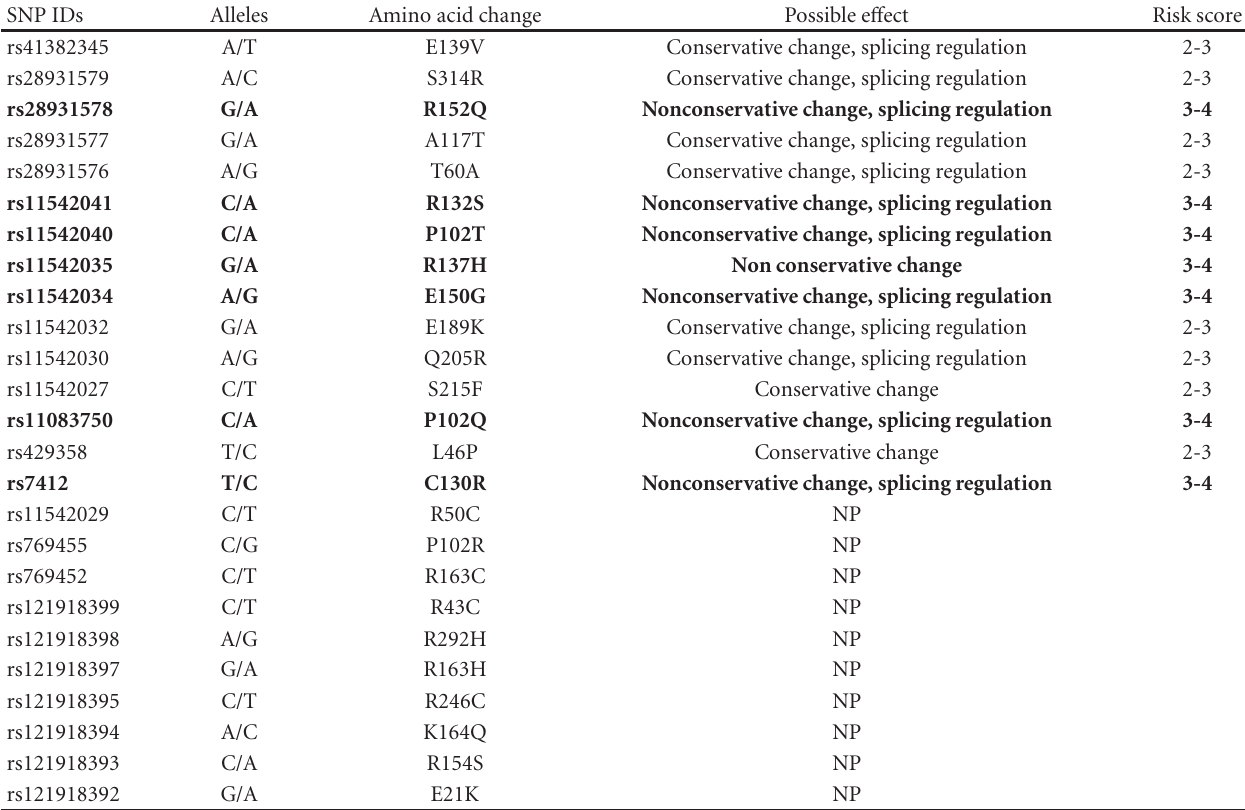
Table 2: Functional e ff ect and estimated risk (FASTSNP).